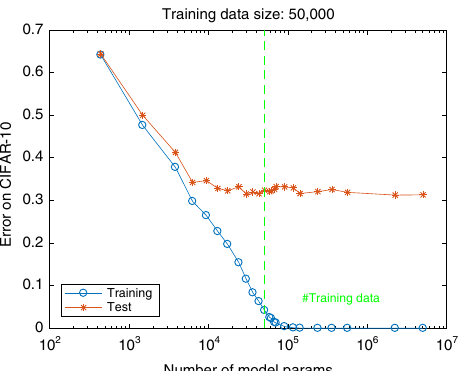
Fig. 2 No over fi tting in deep networks. Empirical and expected error in CIFAR-10 as a function of number of neurons in a 5-layer convolutional network. The expected classi fi cation error does not increase when increasing the number of parameters beyond the size of the